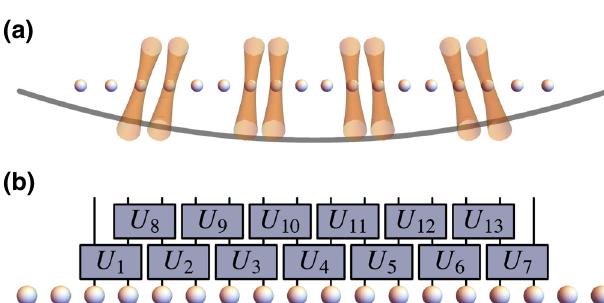
FIG. 8. Schematic setup for dense circuits. (a) In a setup in which pairs of ions that are pinned and not pinned alternate, gates can be performed on all ions in parallel. This leads to the realization of dense circuits as illustrated in (b). Maintaining high fidelity and low crosstalk in such circuits requires optimal coherent control